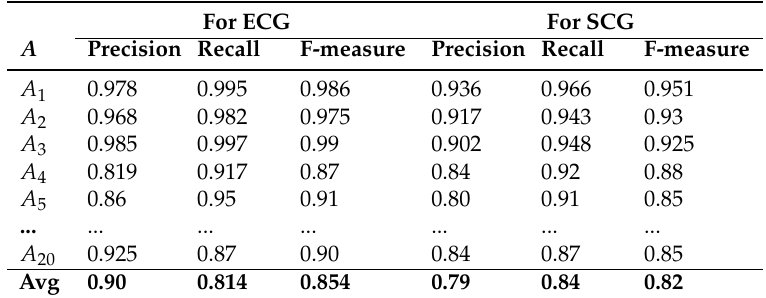
Table 10. Performance evaluation of ECG and SCG feature points delineation mechanisms considering all 20